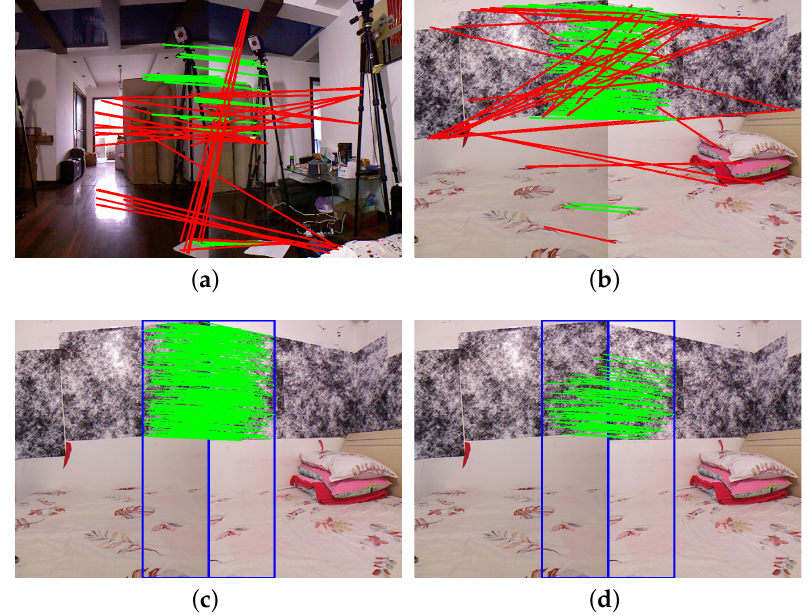
Figure 4. ( a ) Shows the matched keypoints of the image pairs captured in a natural scene. ( b – d ) shows the matched keypoints of the image pairs captured in a scene with descriptor-based calibration patterns. The keypoints are detected in the whole image in ( b ), and in the image regions within blue rectangles in ( c , d ). The matched keypoints in ( a – c ) are accepted if its descriptor distance is below a threshold, ( d ) shows the matched keypoints when the RANSAC-based method is applied to refine the matched keypoints in ( c ). Well-matched keypoints are connected with green lines, poorly matched keypoints are connected with red